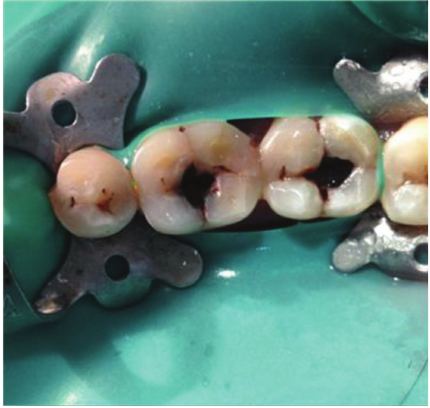
Figure 14: Preoperative photograph: 36,